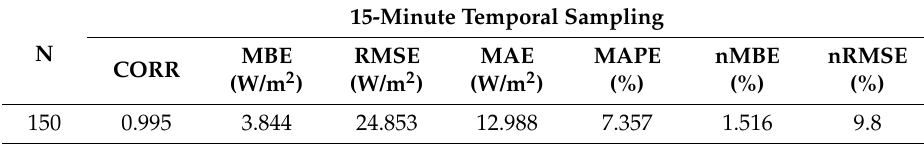
Table 8. Statistical analysis for the 15-minute AMESIS temporal sampling product against ground measurements at the JRC (Ispra) site, considering the whole dataset. N = the total number of hourly mean irradiance values.